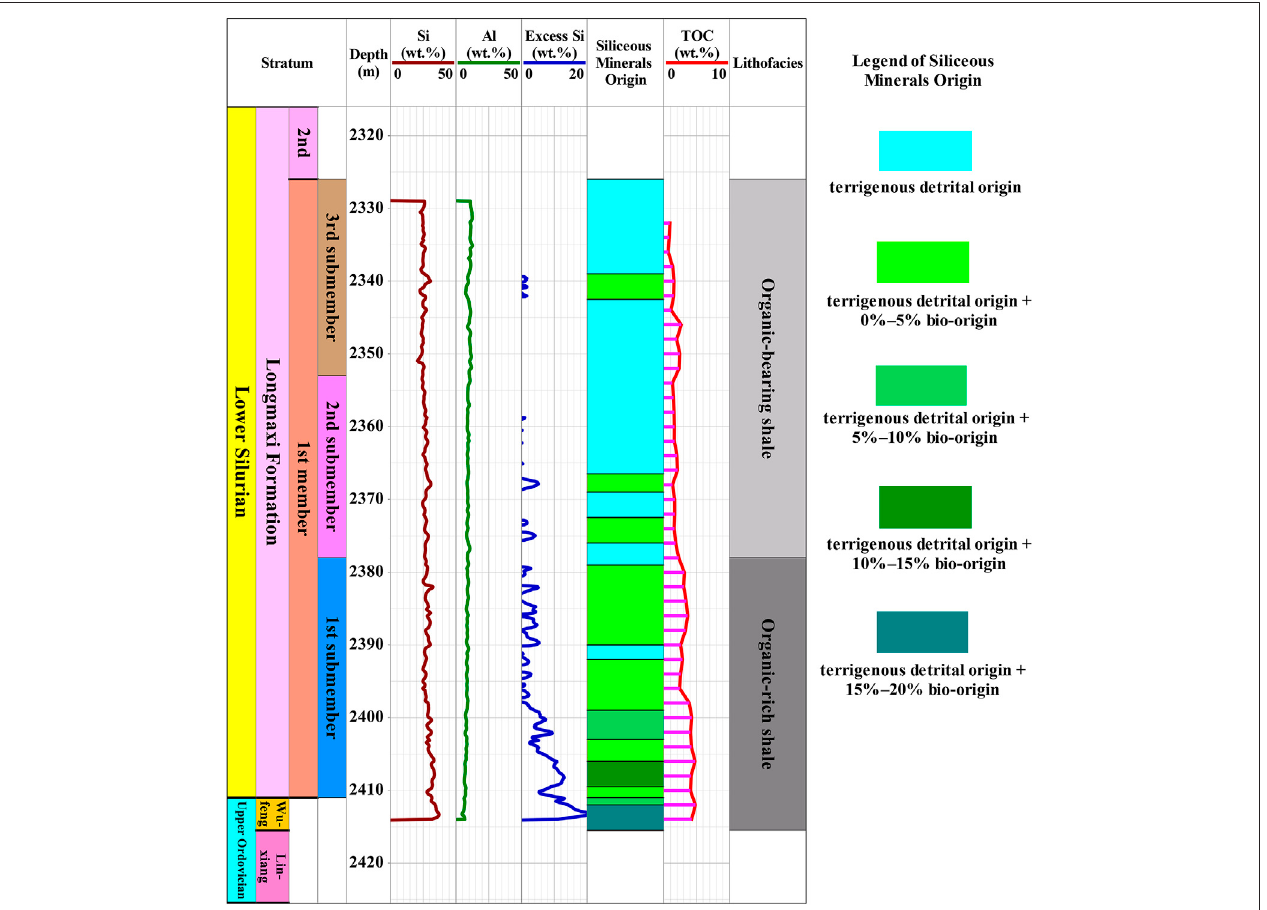
FIGURE3| QuantitativeanalysisofsiliceousmineralsinmarineshaleswithdifferentTOCcontentsinthe fi rstmemberofLowerSilurianLongmaxiFormationinJiao Ye 1 well, Yangtze area. See Figure 1 for the well location.